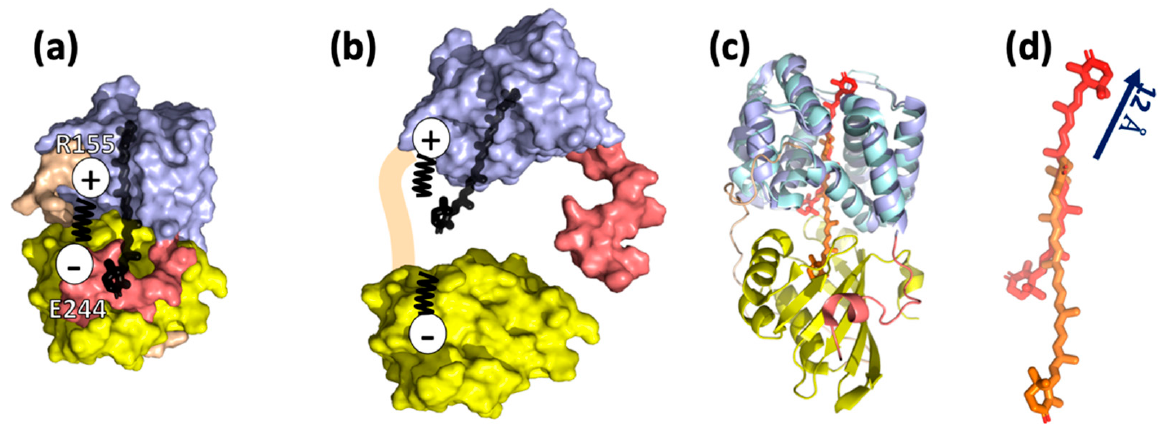
Figure 3. Current knowledge on OCP R structure. ( a ) Crystal structure of Synechocystis sp. PCC6803 OCP O (PDB ID code 5TV0) consisting of two domains, NTD and CTD, NTE and the loop as shown in Figure 1. The salt bridge R155-E244 plays an important role in connecting the two domains. ( b ) The model of OCP R by Leverenz et al. [15,22]: NTD and CTD are partially or entirely separated, promoted by salt bridge disruption, and keto-carotenoid is translocated into NTD [21]. ( c ) Comparison of OCP O (5TV0, coloring according to Figure 1) and RCP (amino acids and the keto-carotenoid are colored with cyan and red, respectively). ( d ) Superposition of NTD and RCP demonstrates 12 Å translocation of keto-carotenoid inside the protein network. This translocation is considered to be present in OCP R [15].